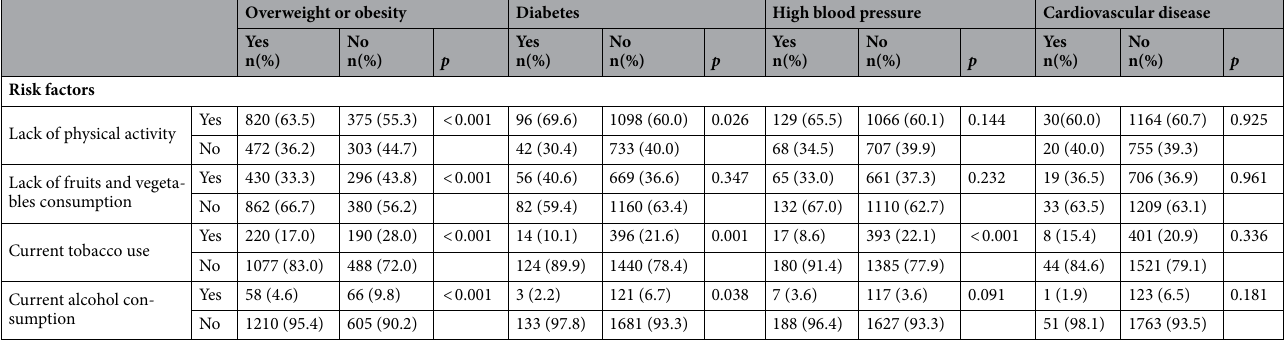
Table 2. Prevalence of cardiovascular risk factors among participants according to their health